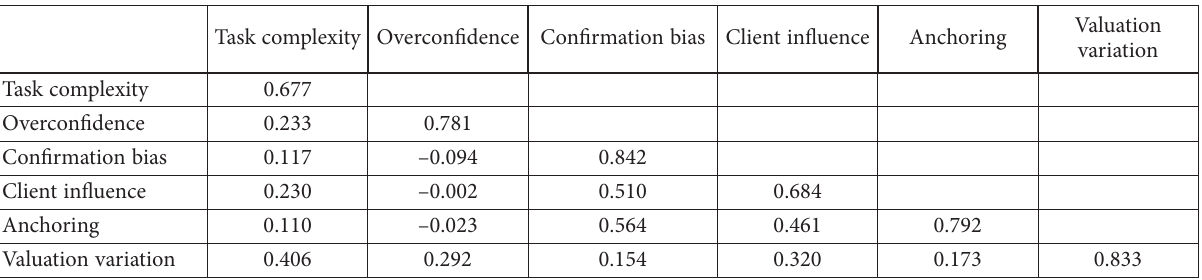
Table 4. Correlational matrix of the latent variables